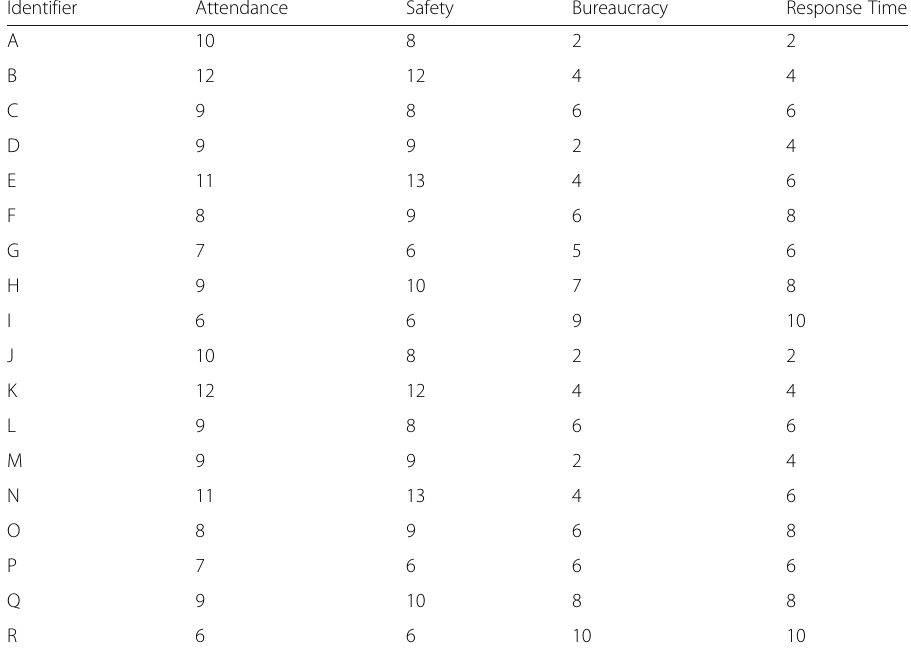
Table 5 Scoring alternatives for